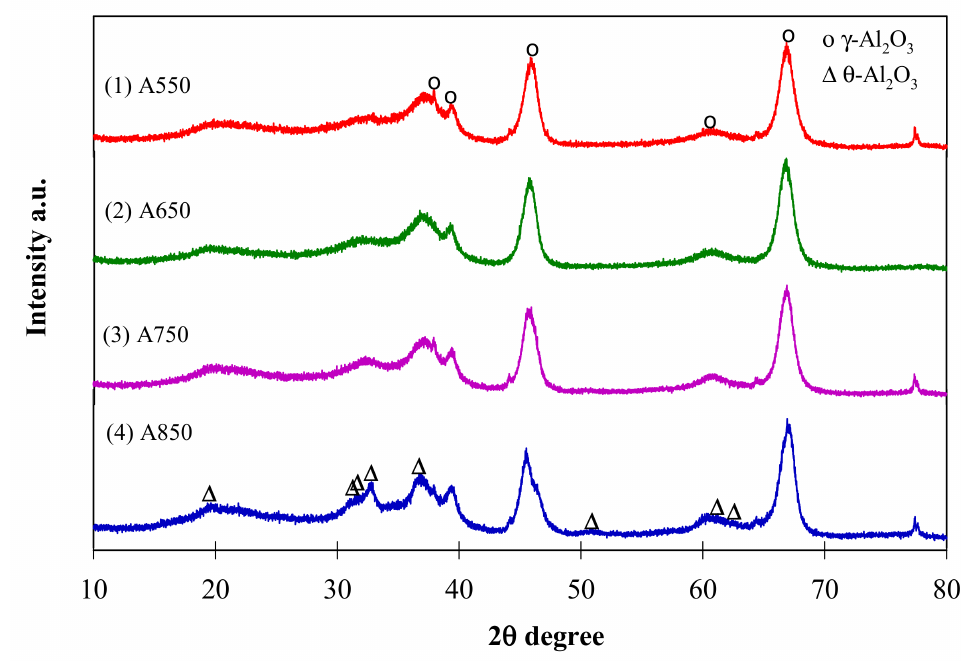
Figure 3. XRD patterns of γ -Al 2 O 3 obtained at different calcination temperatures.